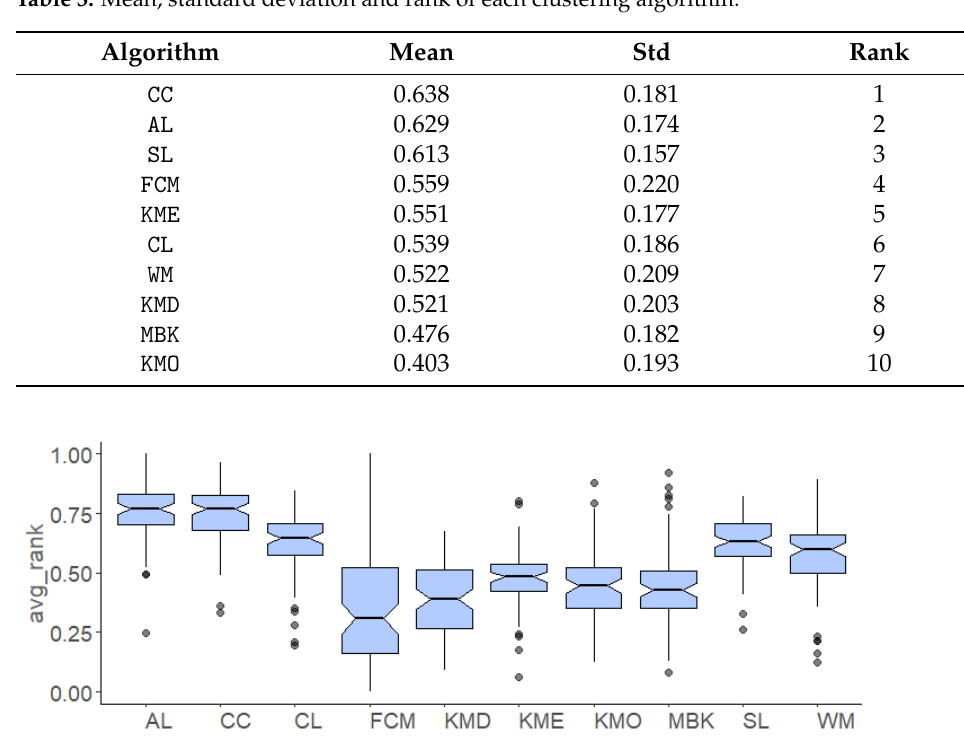
Table 3. Mean, standard deviation and rank of each clustering algorithm.